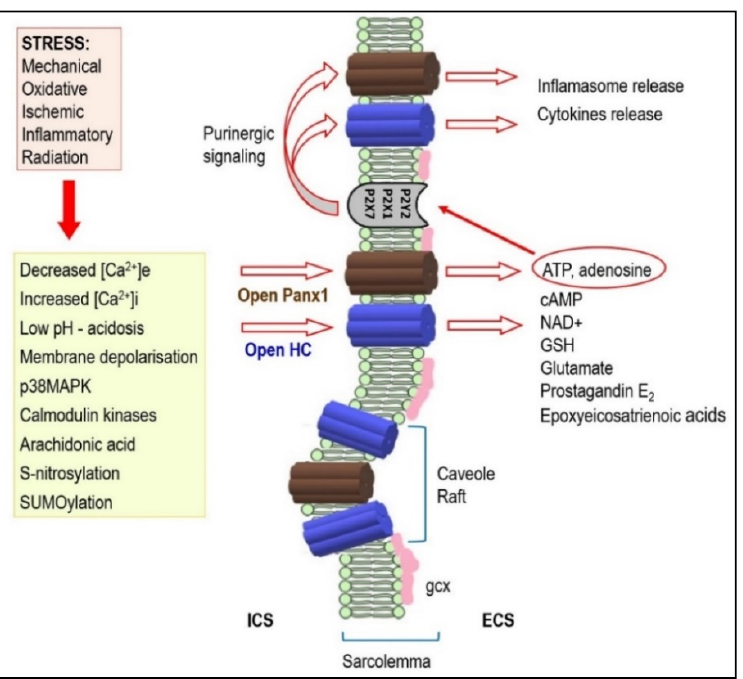
Figure 2. Under stressful conditions, several intracellular signals regulate hemi-channels (HCs) opening. Activated HCs enables release of signaling molecules to the extracellular environment. Therefore, it acts as a paracrine and autocrine communication pathway. HCs mediated ATP release is important in the purinergic signaling which is so important in cardiac pathophysiology. It may also be implicated in arrhythmogenesis (see text for details). Abbreviations: ICS—intracellular space, ECS—extracellular space,